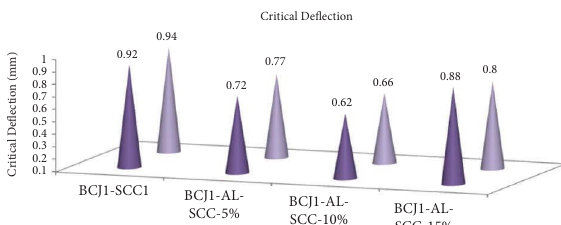
Figure 12: Ultimate defection vs. BCJ specimens.